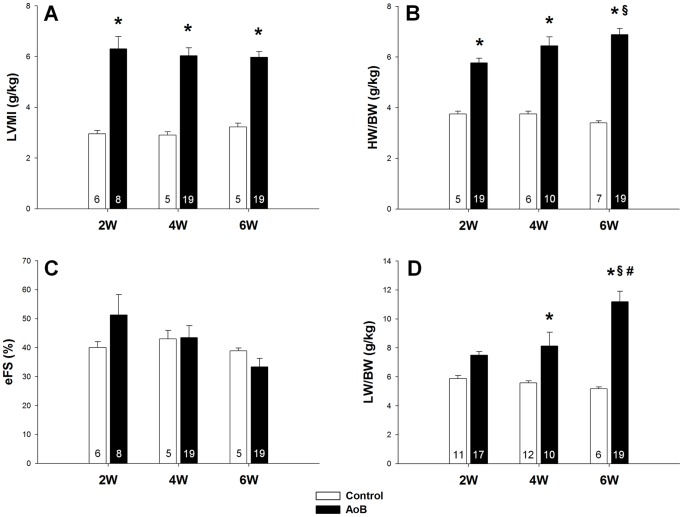
Six weeks of pressure overload induced hypertrophy and lung remodeling despite preserved systolic function.(A): Left ventricular mass index (LVMI), (B): heart weight-to-body weight ratio (HW/BW), (C): endocardial fractional shortening (eFS) and (D): lung weight-to-body weight ratio (LW/BW) of control and pressure overloaded rats at 2, 4 and 6 weeks after aortic banding (AoB). Data are mean ±SEM. Significantly different vs. age-matched control: *, vs. AoB at 2 weeks: §, vs. AoB at 4 weeks: #. The numbers in the bars indicate group size.